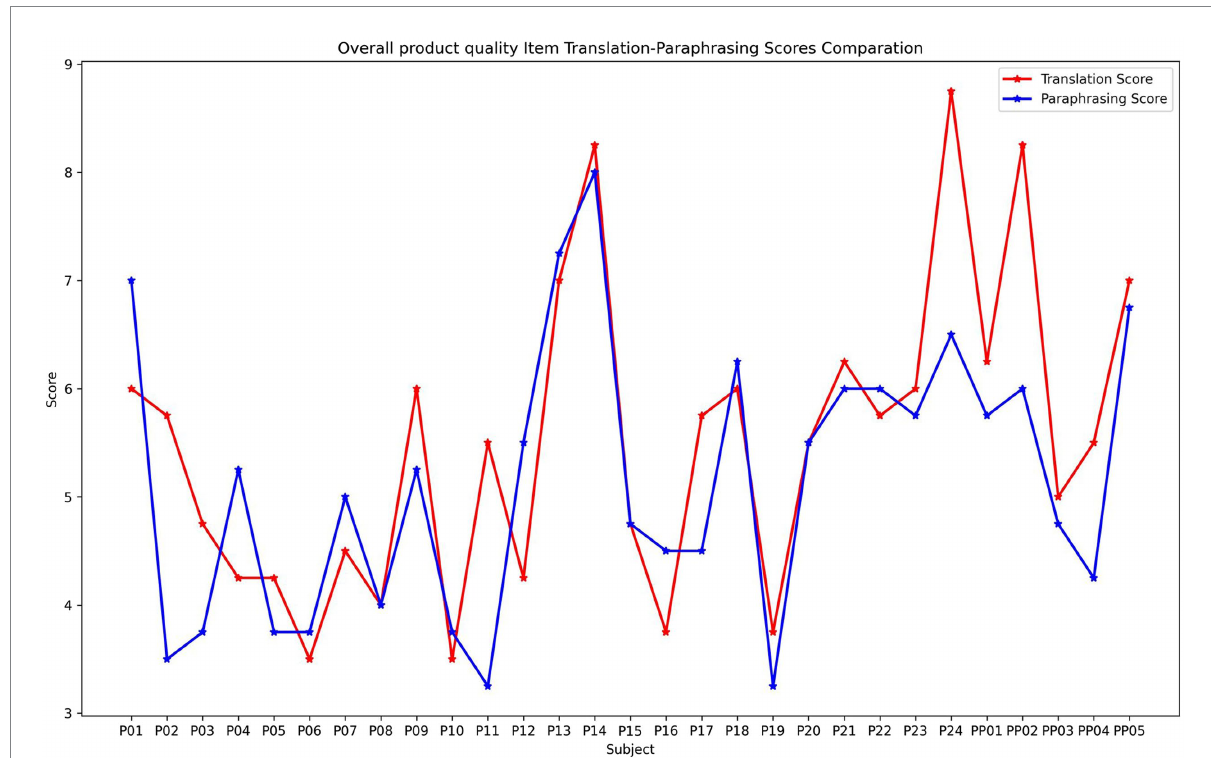
FIGURE 5 Average rating scores in Overall Product Quality in translation and paraphrasing among 29